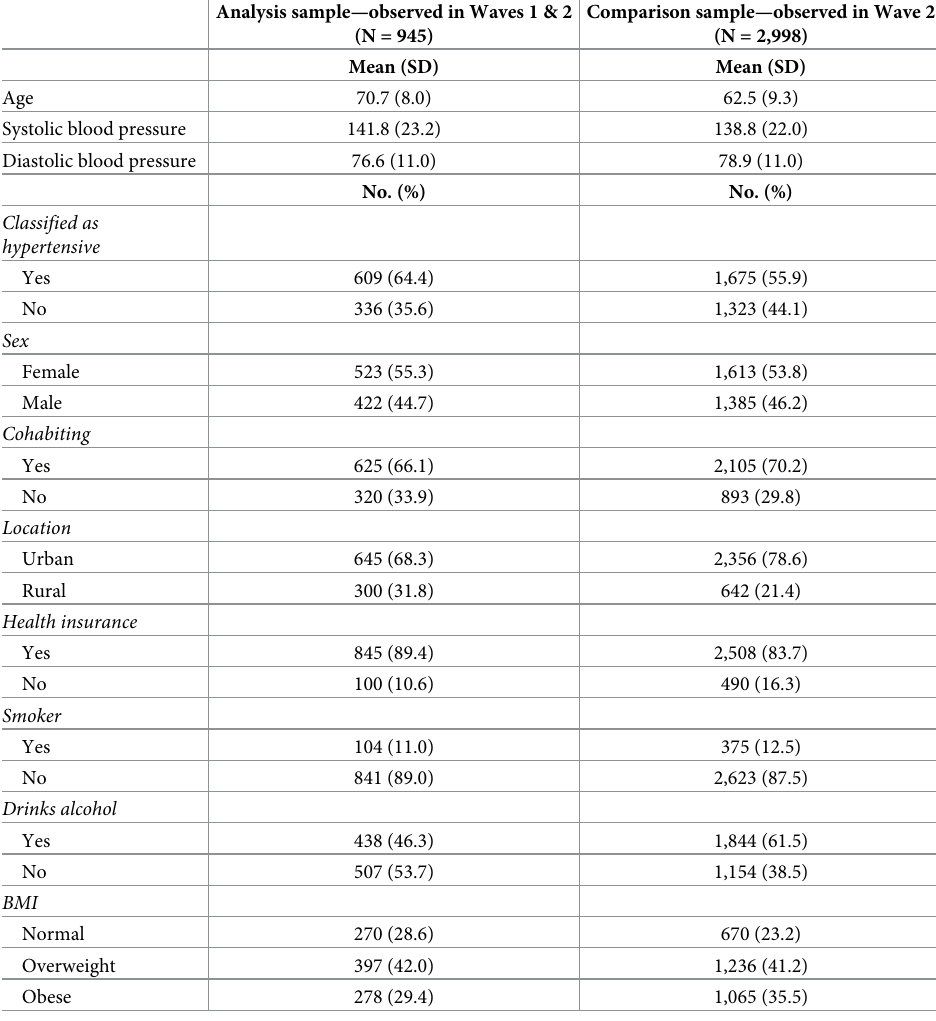
Table 2. Sample characteristics, aged 50 years and older years in 2014 (Wave